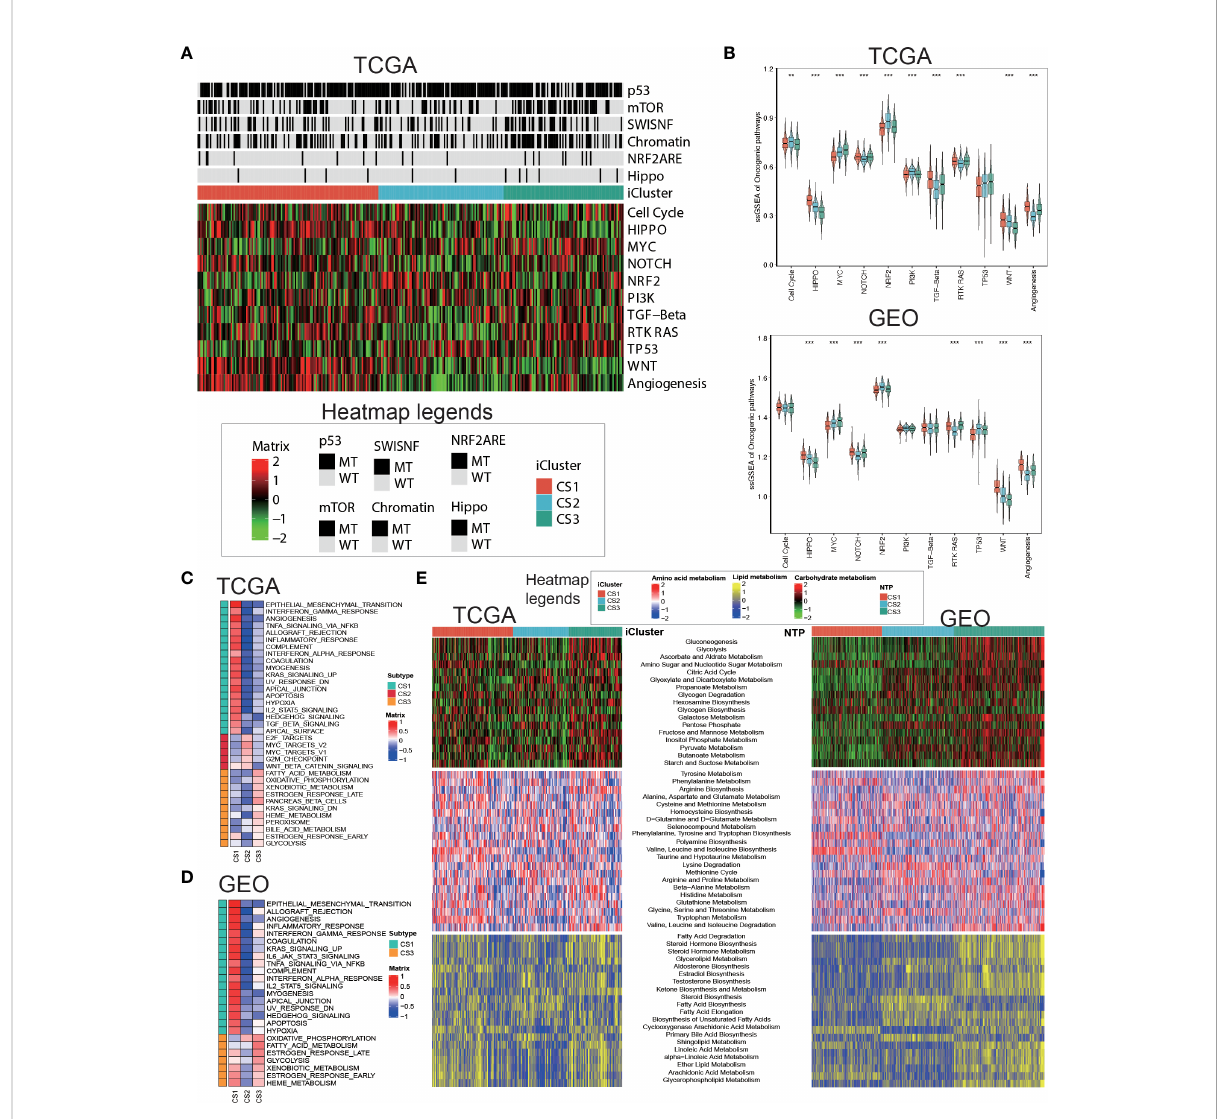
FIGURE 4 Delineation of metabolism-related pathways in colorectal cancer subtype. (A) Oncogenic heatmap with cancer associated mutations in tcga coadread. (B) Boxplot for oncogenetic pathways in iclusters of tcga coadread. (C) Upregulated hallmark pathway heatmap in tcga_using_upregulated_pathways. (D) Upregulated hallmark pathway heatmap in geo_using_upregulated_pathways. (E) Heatmap showing transcriptome enrichment score of three metabolic categories in TCGA and GEO cohorts. **p < 0.01; ***p <